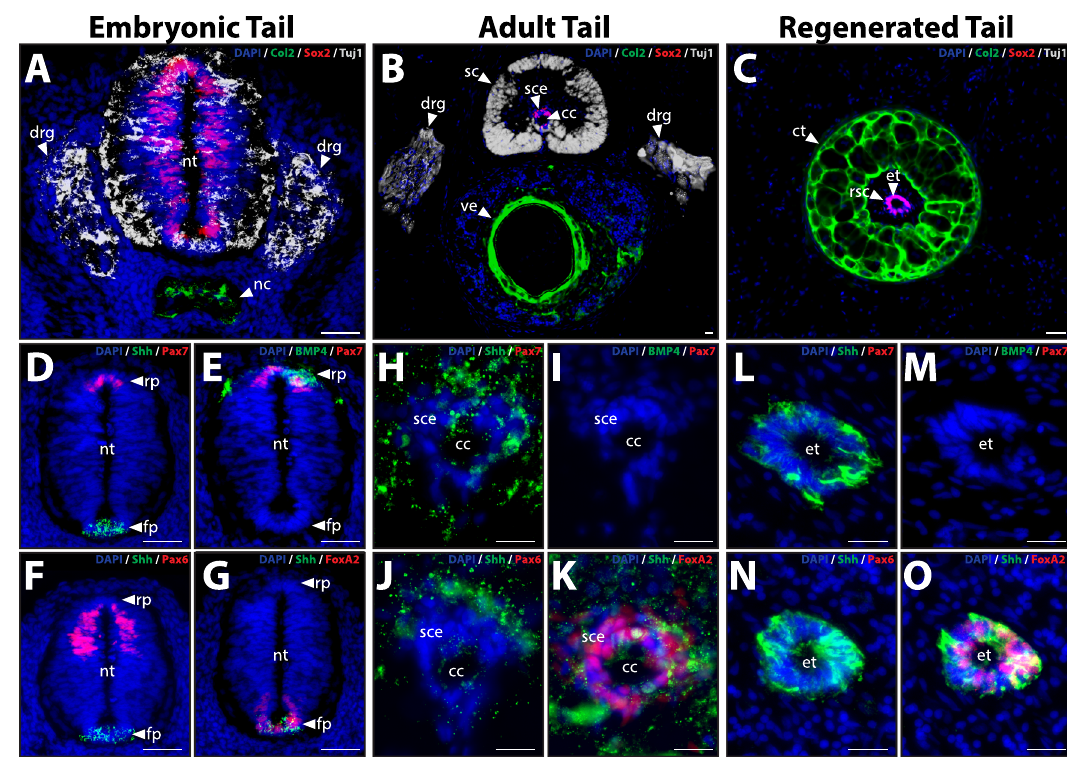
Fig. 1 Dorsoventral patterning of skeletal and CNS tissues established during embryogenesis is not recapitulated during lizard tail regeneration. Cross sections of A embryonic (14 days post-oviposition; DPO), B adult (28 days post hatching; DPH), and C regenerated lizard tails (28 days post-amputation; DPA) were analyzed by Col2, Sox2, and Tuj1 IF to highlight the spatial arrangements of skeletal (cartilage), NSC, and nerve tissue, respectively, during tail development and regrowth. D – O Cross sections of NT and spinal cord ependymal structures were analyzed by Pax7, Pax6, Shh, and FoxA2 IF to compare the expression of roof plate, lateral domain, and fl oor plate identities among D – G embryonic, H – K adult, and L – O regenerated tails. Ten tails belonging to each developmental/regenerative stage were analyzed. cc central canal, ct cartilage tube, DPA days post-amputation, DPO days post-oviposition, DPH days post hatching, drg dorsal root ganglion, et ependymal tube, fp fl oor plate, nt neural tube, rp roof plate, rsc regenerated spinal cord, sc spinal cord, sce spinal cord ependyma. Bar = 50 µ